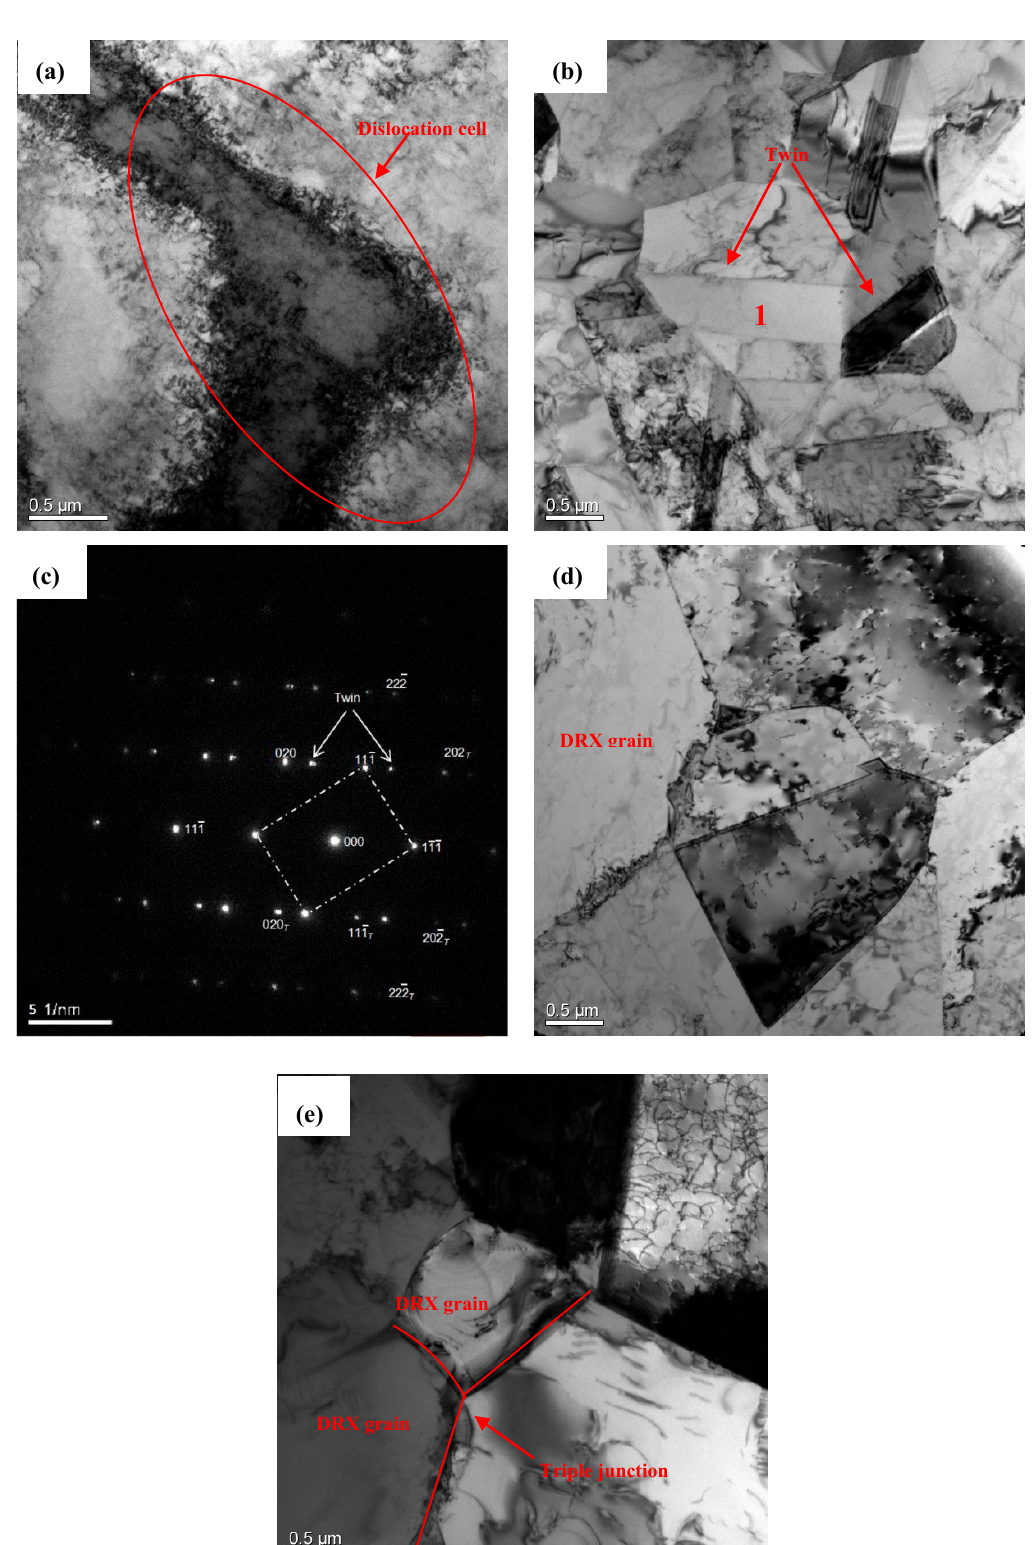
Figure 13. The dislocation substructures in the deformed specimens under the strain rate of 1 s − 1 :( a ) 960 °C, ( b ) 1000 °C, ( c ) corresponding SAED patterns at in ( b ), ( d ) 1060 °C, ( e ) 1120 °C.